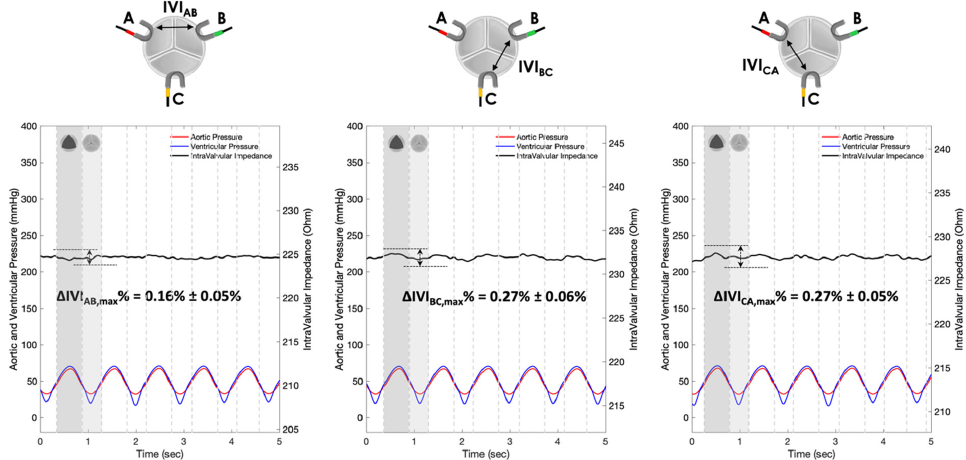
Figure 14. IVI measurements recorded for the three pairs of electrodes of Prototype 2 under altered leaflet dynamics: AB ( left ), BC ( center ) and CA ( right ).